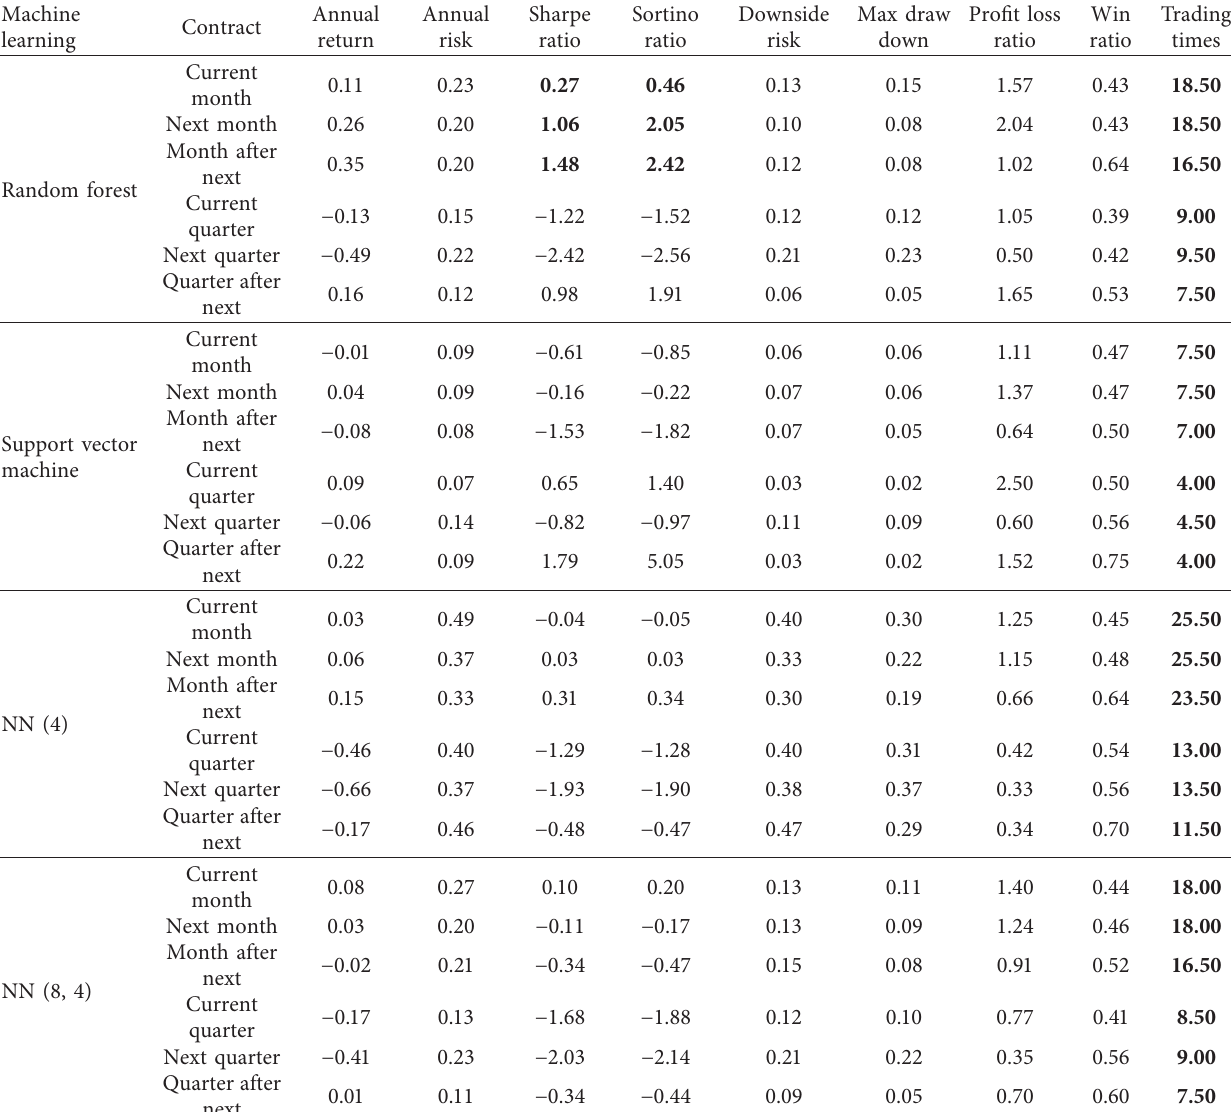
Table 13: Option strategy of predicting the rise and fall of volatility by threshold (use 21 features M3, threshold � 0.5). Machine